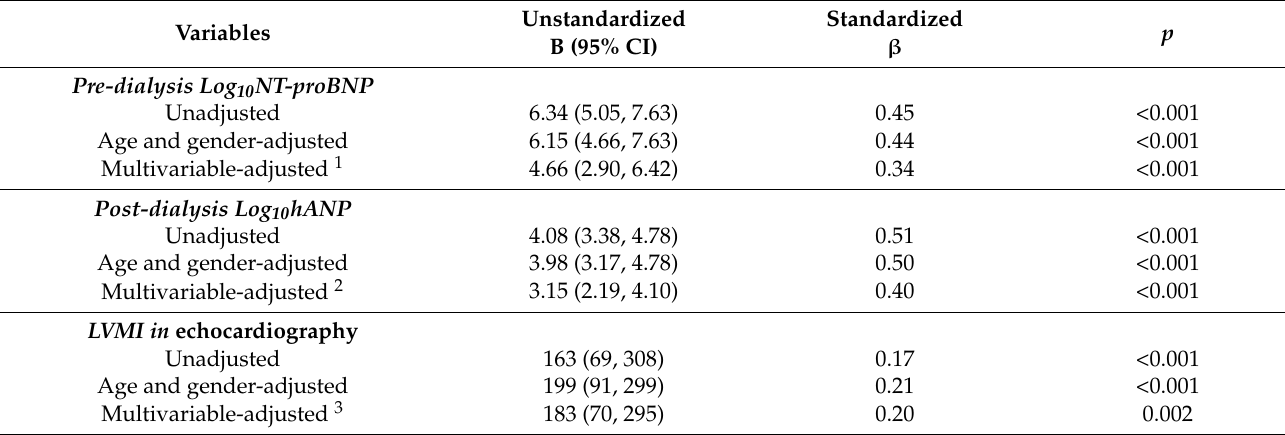
Figure 3. Association between body fluid imbalance and natriuretic peptides according to the fat percentage quartiles. NT-proBNP, pre-dialysis N -terminal pro-B-type natriuretic peptide; hANP, post-dialysis human atrial natriuretic peptide; Q1, Quatile1; Q2, Quatile2; Q3, Quatile3; Q4, Quatile4. 3.4. Body Fluid Imbalance Is an Independent Associated Factor for Natriuretic Peptides and LVMI In the linear regression analysis, the ECW/ICW ratio remained an independent associ- ated factor for log 10 -transformed natriuretic peptides and LVMI (Table 3). We constructed receiver-operating characteristic curves to derive the cut-off values of the ECW/ICW ratio for these cardiac biomarkers. The best cutoff values of the ECW/ICW ratio for NT-pro BNP ≥ 4000 and ≥ 8000 pg/mL were 0.638 and 0.637 in men and 0.652 and 0.660 in women, respectively. The best cutoff values of the ECW/ICW ratio for hANP ≥ 75 and ≥ 100 pg/mL were 0.624 and 0.632 for men and 0.653 and 0.685 for women, respectively. Table 3. Extracellular to intracellular water ratio as an independent factor associated with NT-proBNP, hANP, and